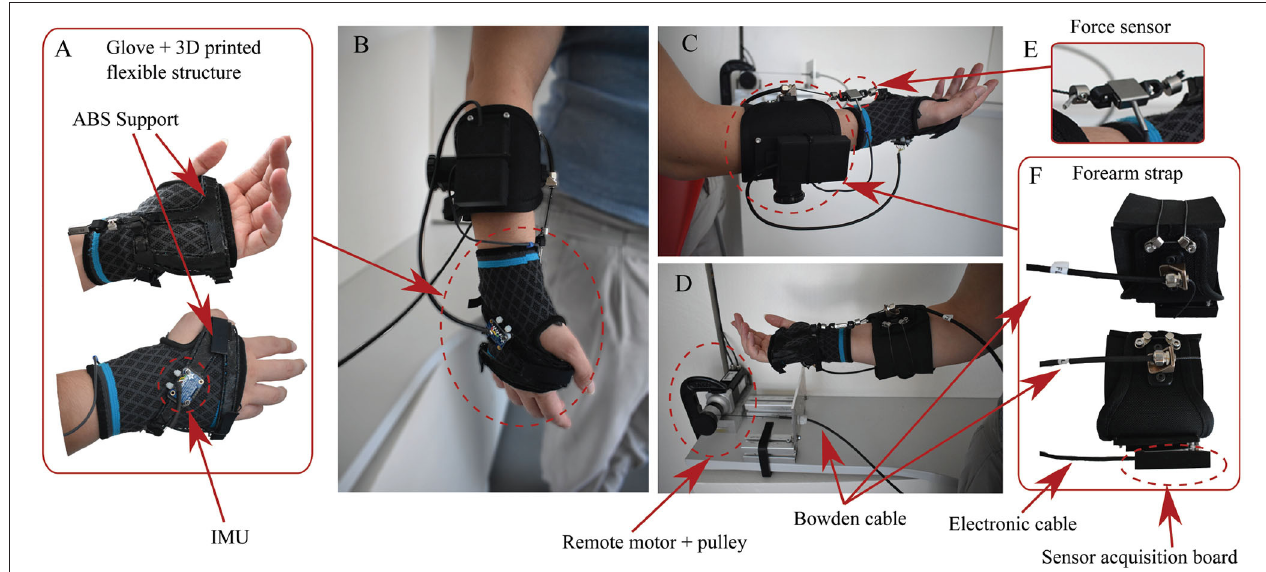
FIGURE 2 | Design of the soft exosuit of the wrist (B–D) . The exosuit comprises a glove that is reinforced through a flexible 3D-printed structure (A) and a strap that wraps around the forearm (F) . These two act as anchor points: the Bowden cables’ outer sheath is attached to the forearm strap and the inner tendons to the glove palm’s end. A load cell (E) , an encoder, and an inertial measurement unit (A) sense the interaction force, the wrist flexion angle, and angular speed. The actuation stage comprises a brushless motor, equipped with a gearhead and encoder, that drives a spool around which the suit’s tendons are wrapped (D) . For this first prototype, the actuation stage was fixed on a